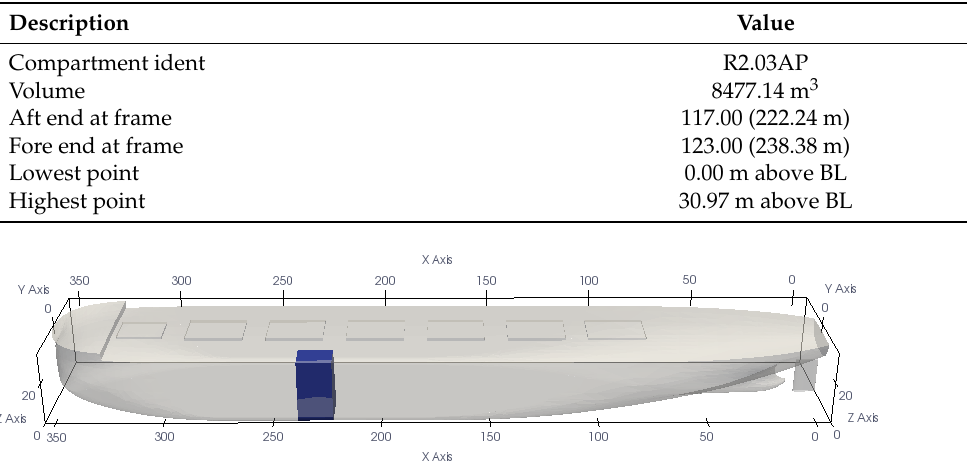
Figure 5. Illustration of the 3D design models of “PACIFIC VISION”.